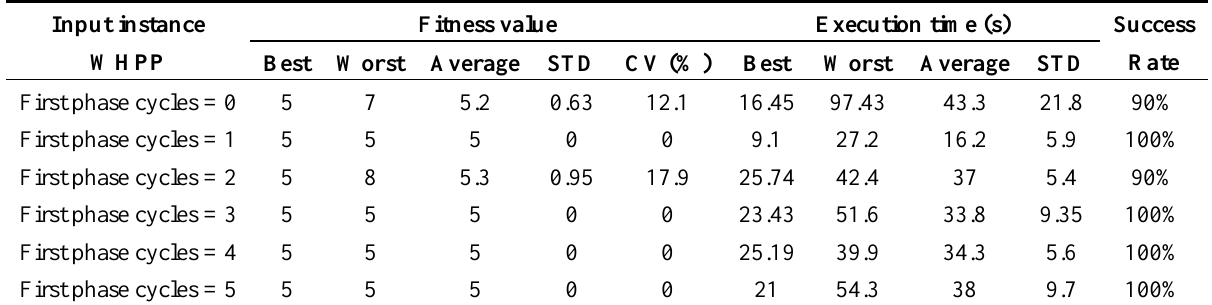
Table 20. Investigating the effect of first phase’s number of cycles for input instance, WHPP.